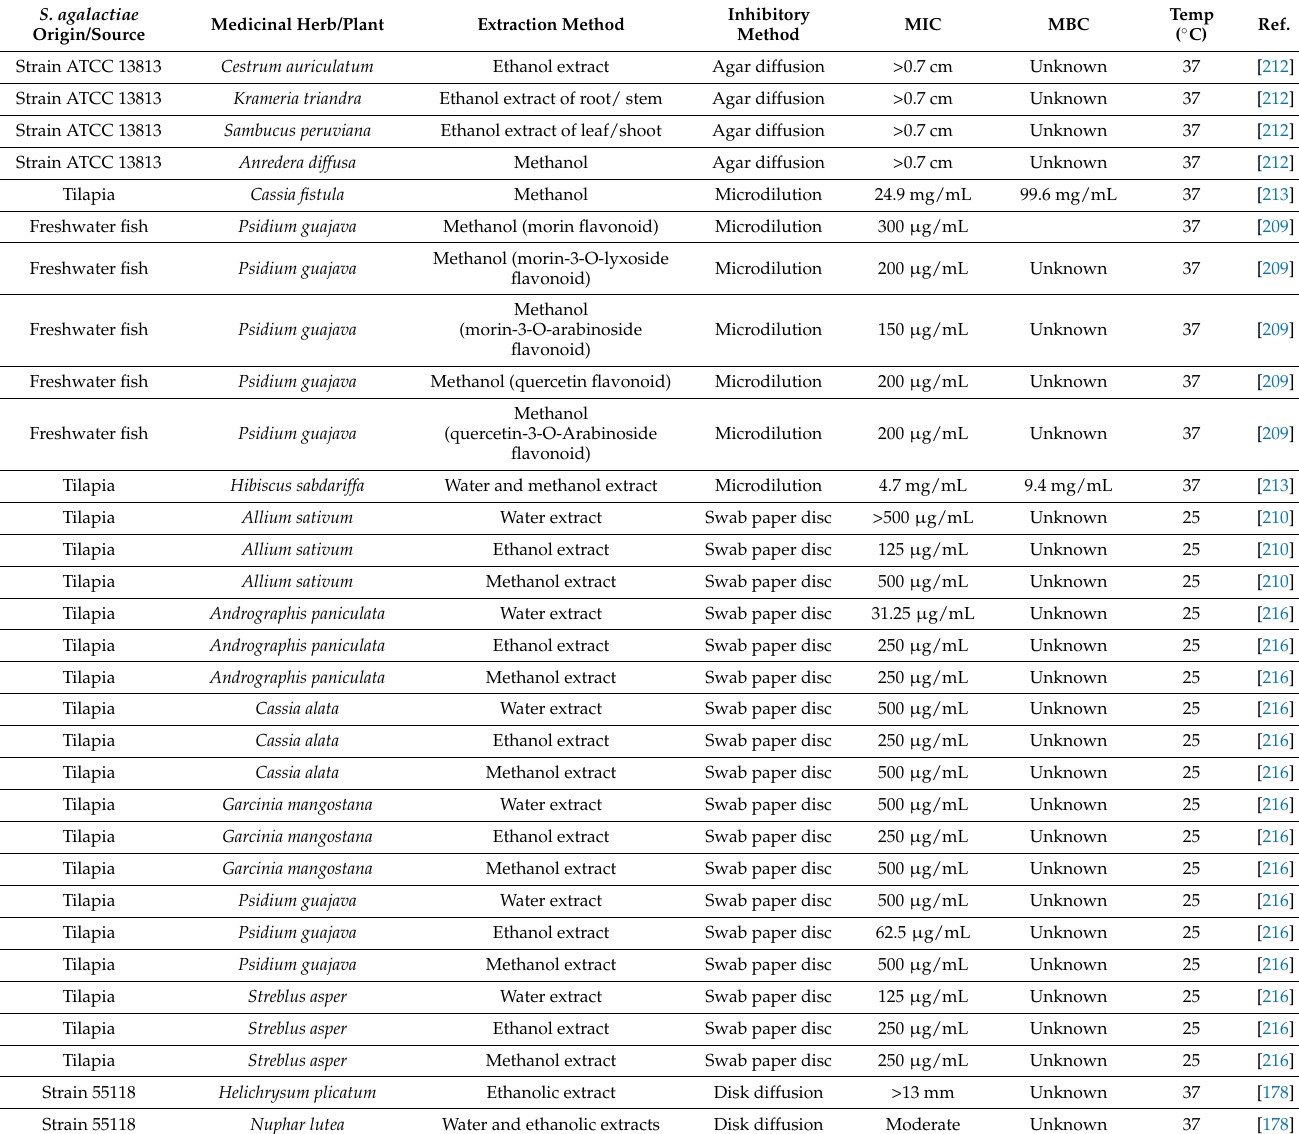
Table 3. In vitro inhibitory activity of medicinal/plants towards S. agalactiae